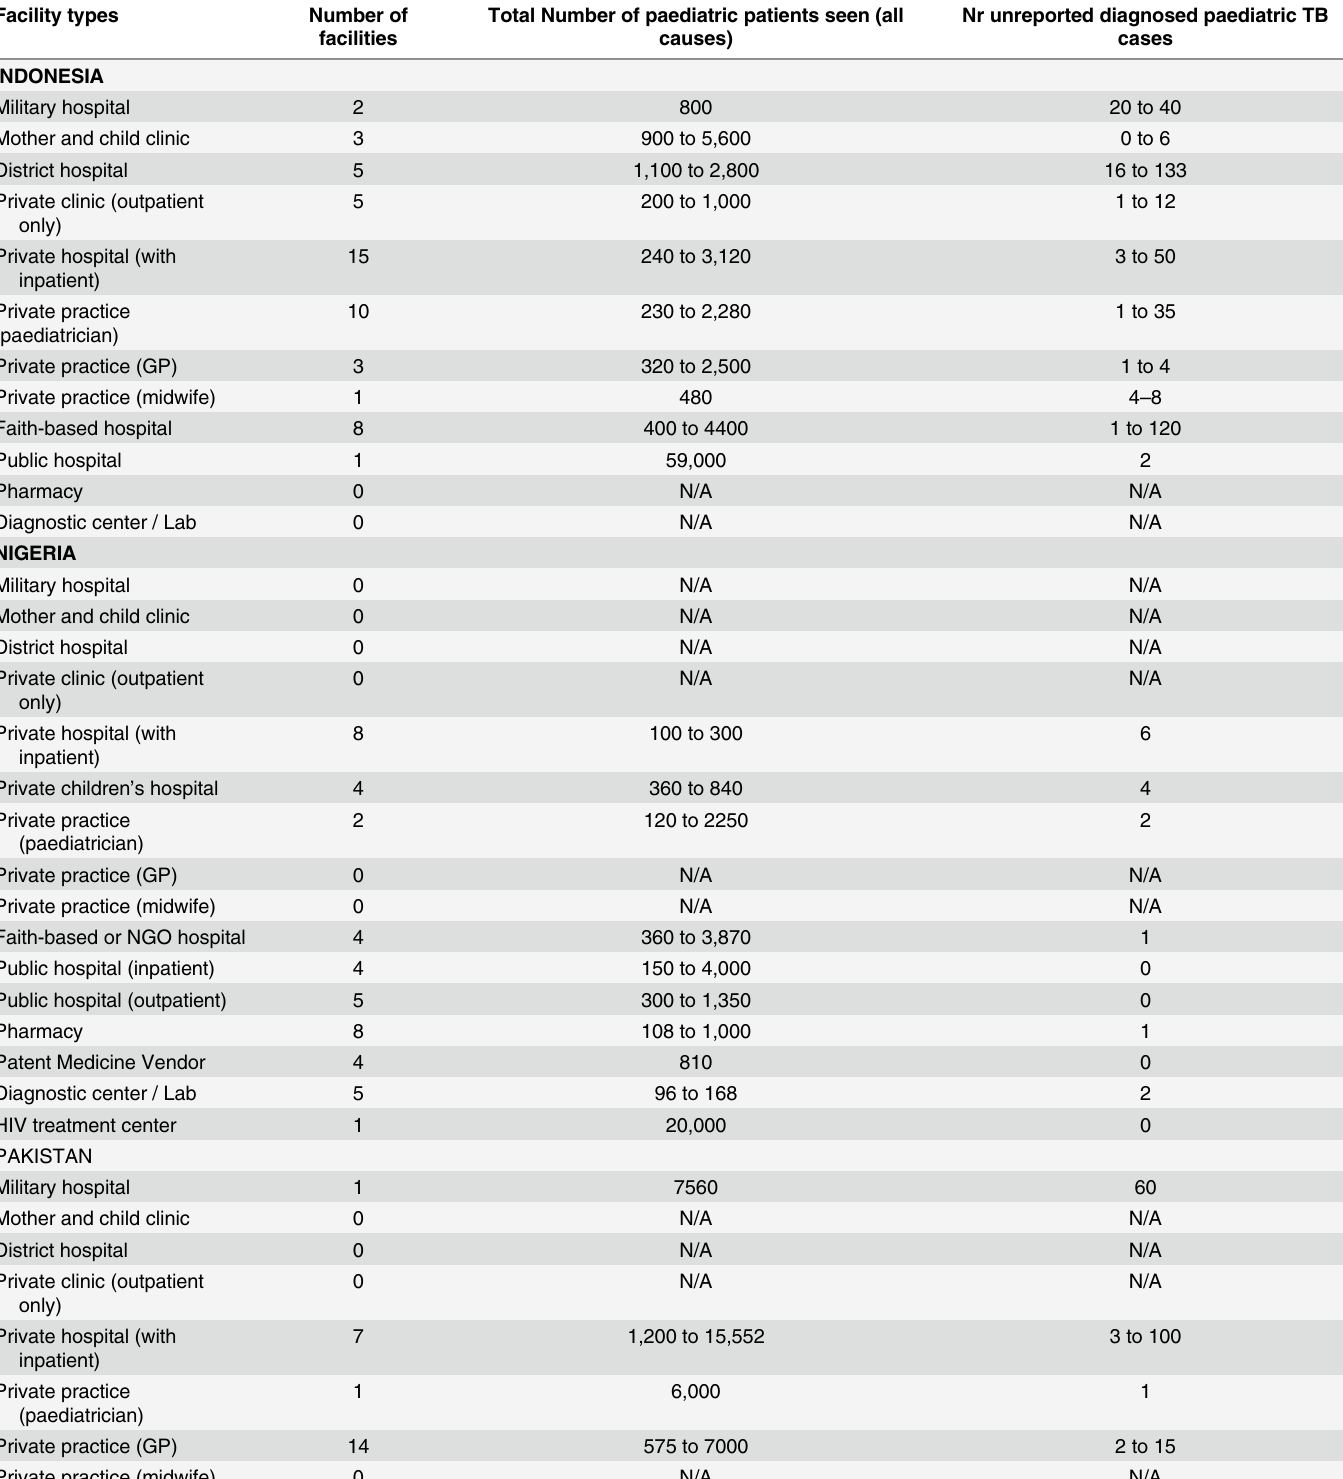
Table 3. Numbers of Paediatric Patients Estimated Per Facility Type and Numbers of Estimated New Paediatric TB